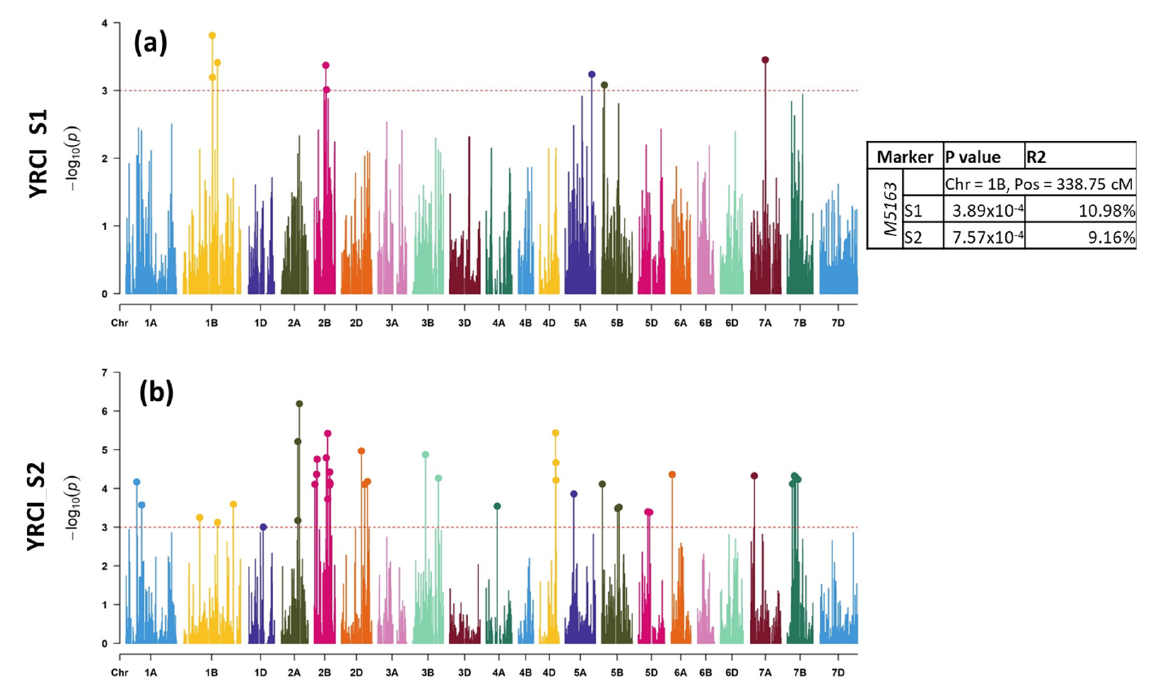
Figure 6. Genome-wide scan of ( a ) YRCI in S1 and ( b ) S2 in the form of Manhattan plots where the chromosomes are plotted at the bottom, and the thin dotted red line indicates significance level at p -value < 0.001 ( − log10 = 3 or more) beyond which an association is counted as true association (highlighted dots). Table on the right shows common MTAs between S1 and S2, showing marker names, chromosome number, position, p -value, and R 2 value in each season.